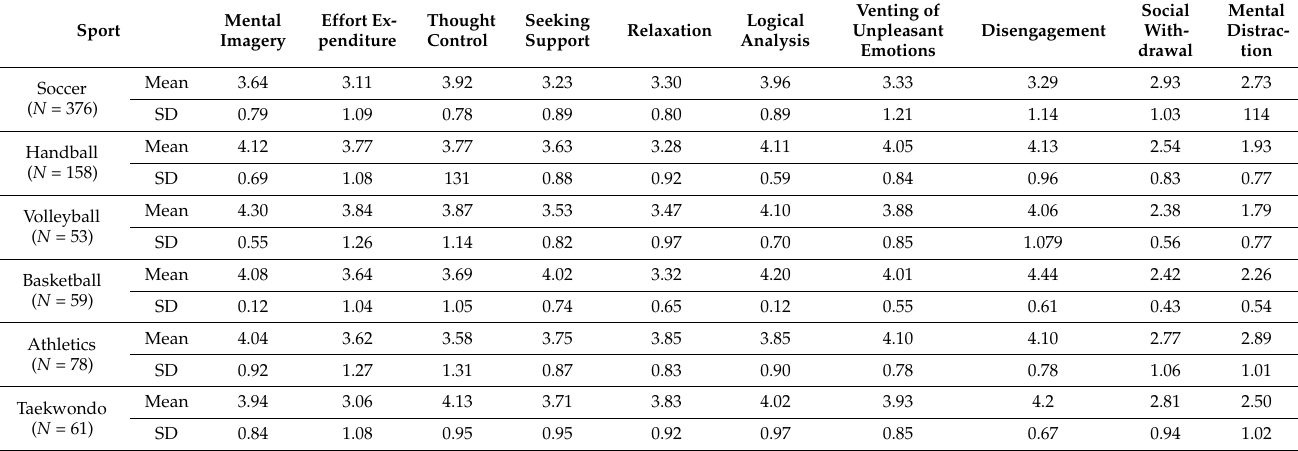
Table 7. First-order coping scores according to sports